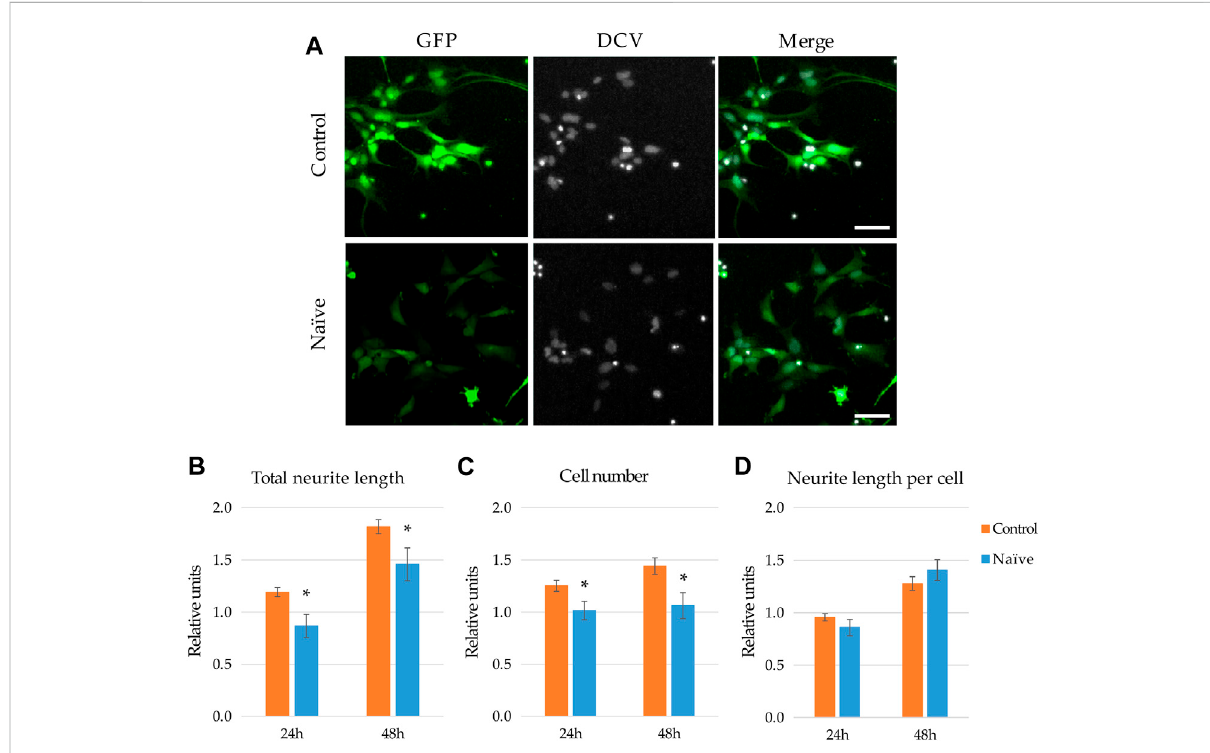
FIGURE 2 Effect of naïve microglia on the neurite outgrowth and proliferation of NPCs. (A) Representative fl uorescence images depict GFP-expressing NPCs (upper panels) and counterparts exposed to the supernatant of naïve BV2 cells for 48 h (lower panels). GFP fl uorescence (green) and counterstainingwiththenucleardyeDCV(grey)areshown.Scalebars:25 µm.Forquantitation,thetotalneuritelengths (B) ,thecellnumber (C) ,and the neurite length per cell (D) were determined at 24 and 48 h. The relative units represent the values normalized to time 0 points of untreated samples. Data are presented as mean ± SEM (n = 8). For statistical analysis, two-way ANOVA followed by Tukey ’ s HSD post hoc test was performed. Asterisks indicate signi fi cant differences as compared to untreated cells (p <